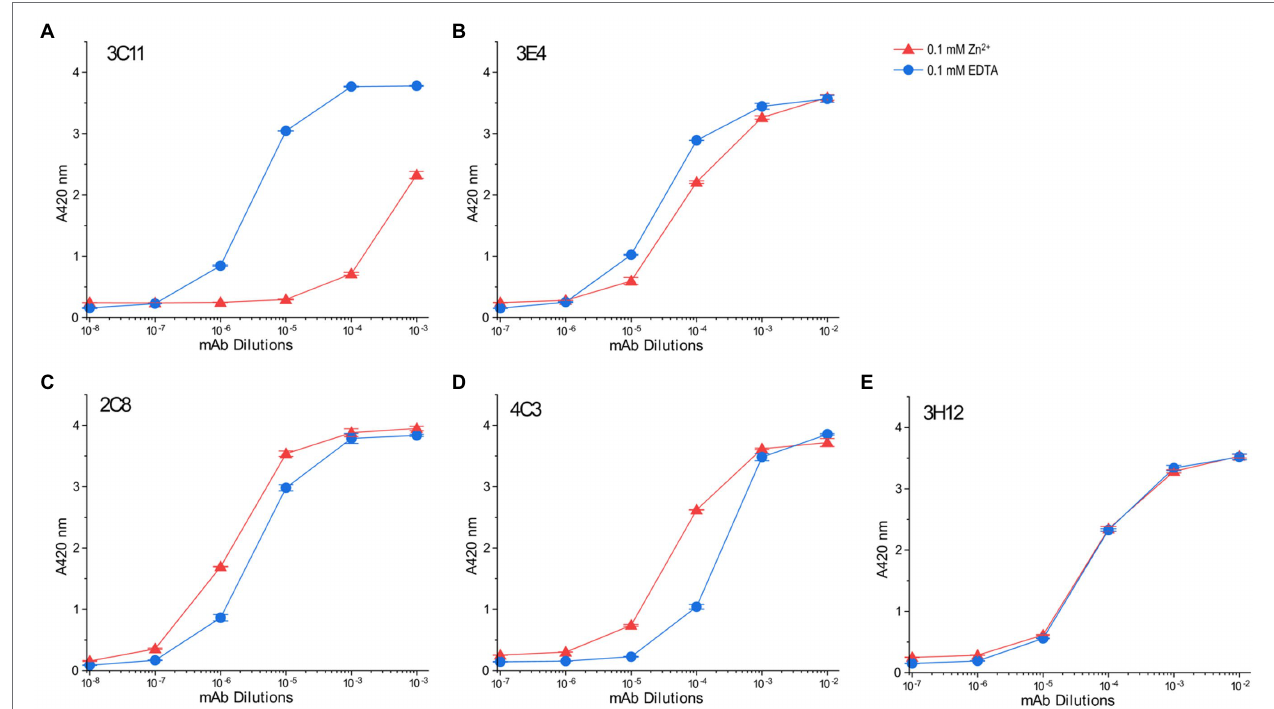
FIGURE 8 | Conformational effect of metal ion binding to chicken fast skeletal muscle TnT8e16 detected by ELISA epitope analysis. (A) Zn 2+ -binding to the N-terminal Tx segment of TnT8e16 resulted in a dramatic decrease in the affinity of anti-Tx mAb 3C11 as compared to the ethylenediaminetetraacetic acid (EDTA) control. (B) mAb 3E4 raised against an epitope related the exon 7-encoded segment downstream of the Tx metal binding site also showed decreased affinity with the binding of Zn 2+ , though less dramatic, reflecting conformational effects propagated from the metal-Tx binding. (C) Zn 2+ binding to the Tx segment enhanced